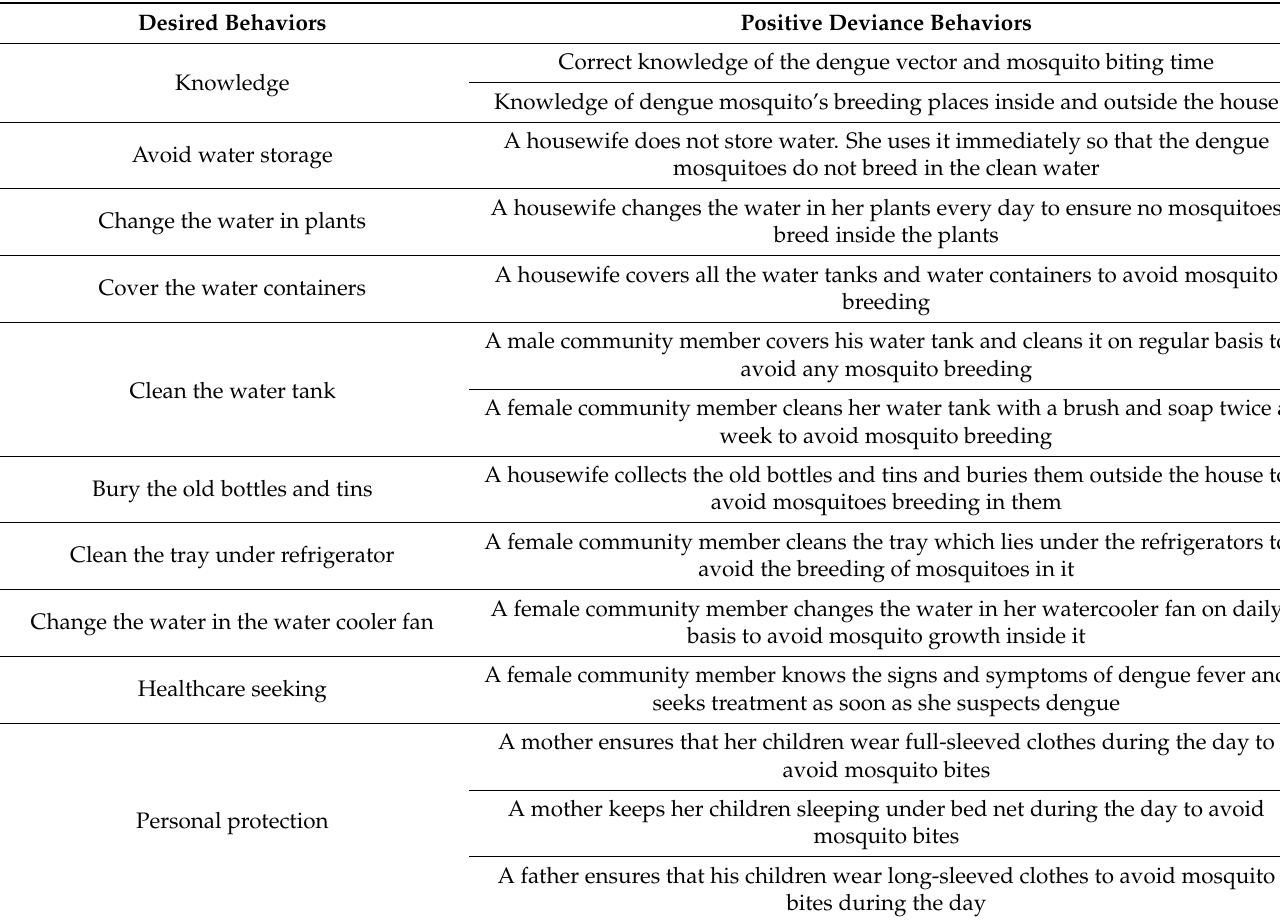
Table 1. Positive deviant behaviors identified during the PD process in Islamabad